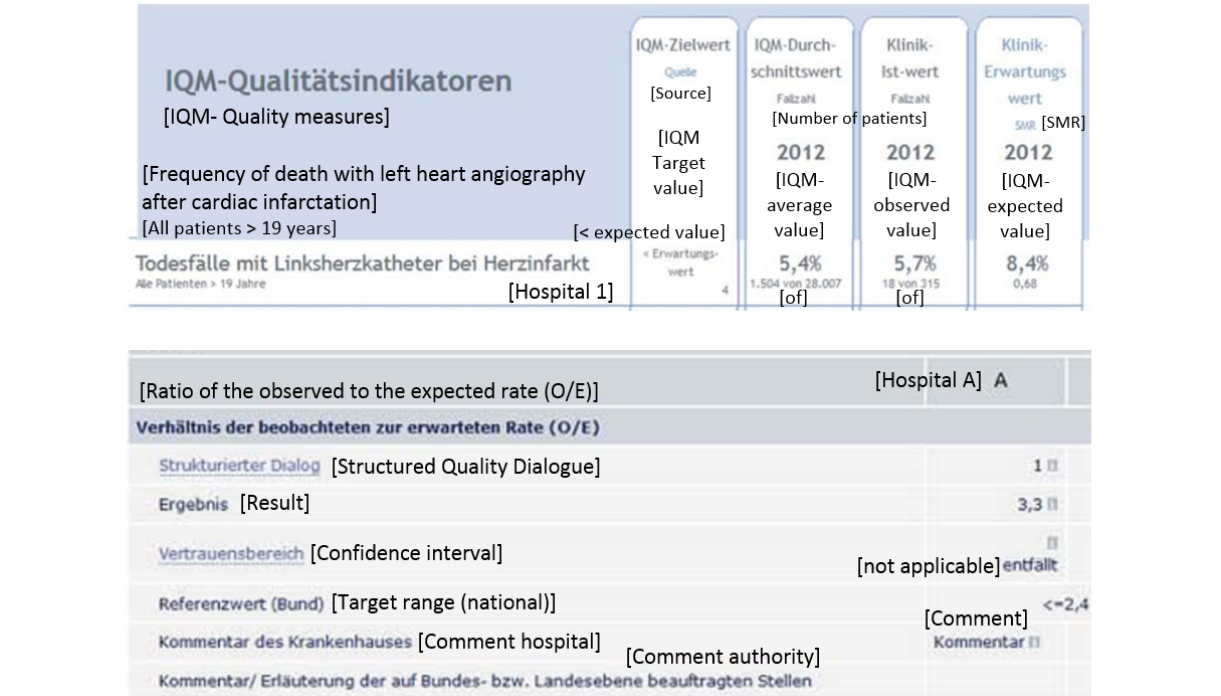
Figure 1. Tables without symbols. Top: Portal E; bottom: Portal G. Only results for hospital 1 are displayed. English translations in